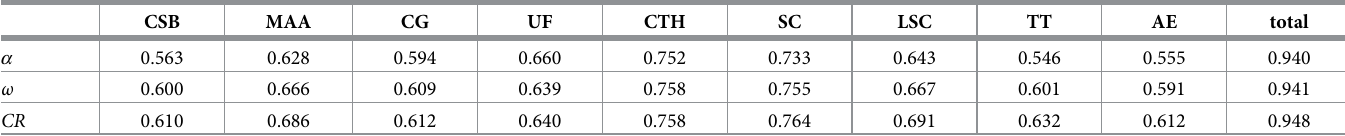
Table 4. Results of the internal reliability tests for the DFS-BR. CSB